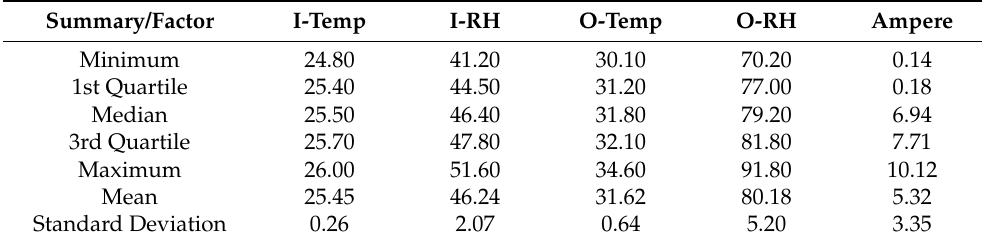
Table 4. Summary of good airflow